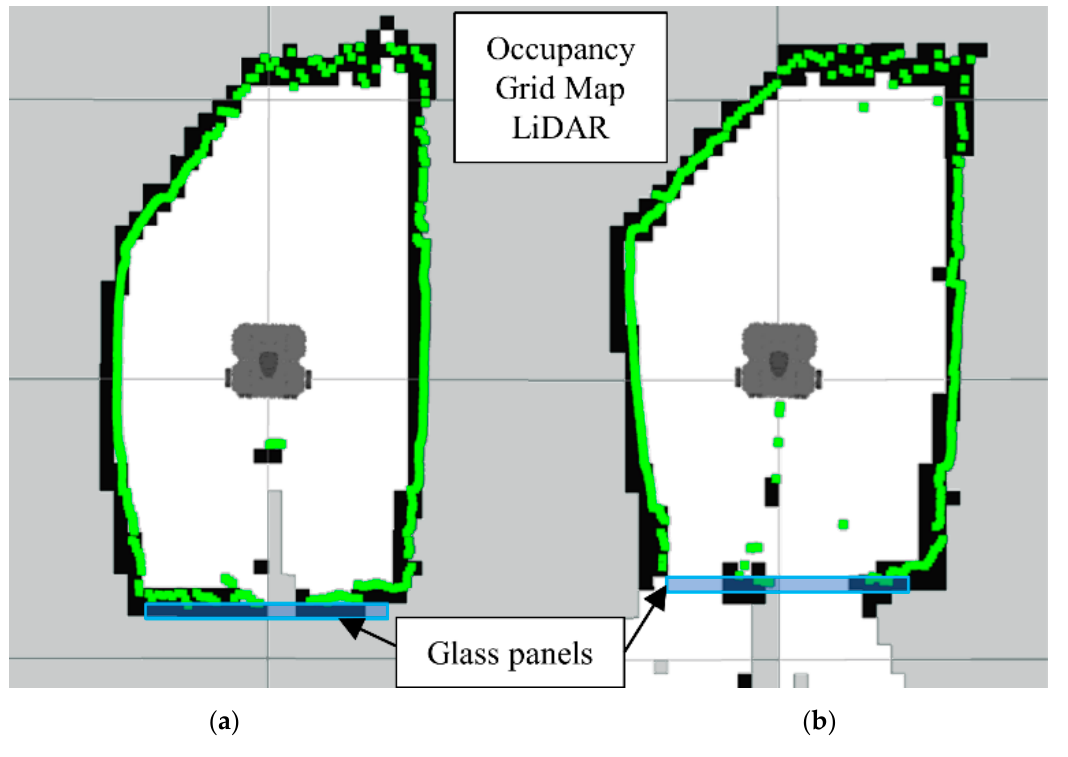
Figure 13. Occupancy grid maps showing the: ( a ) Ground truth (reference map); ( b ) LiDAR gener- ated map.